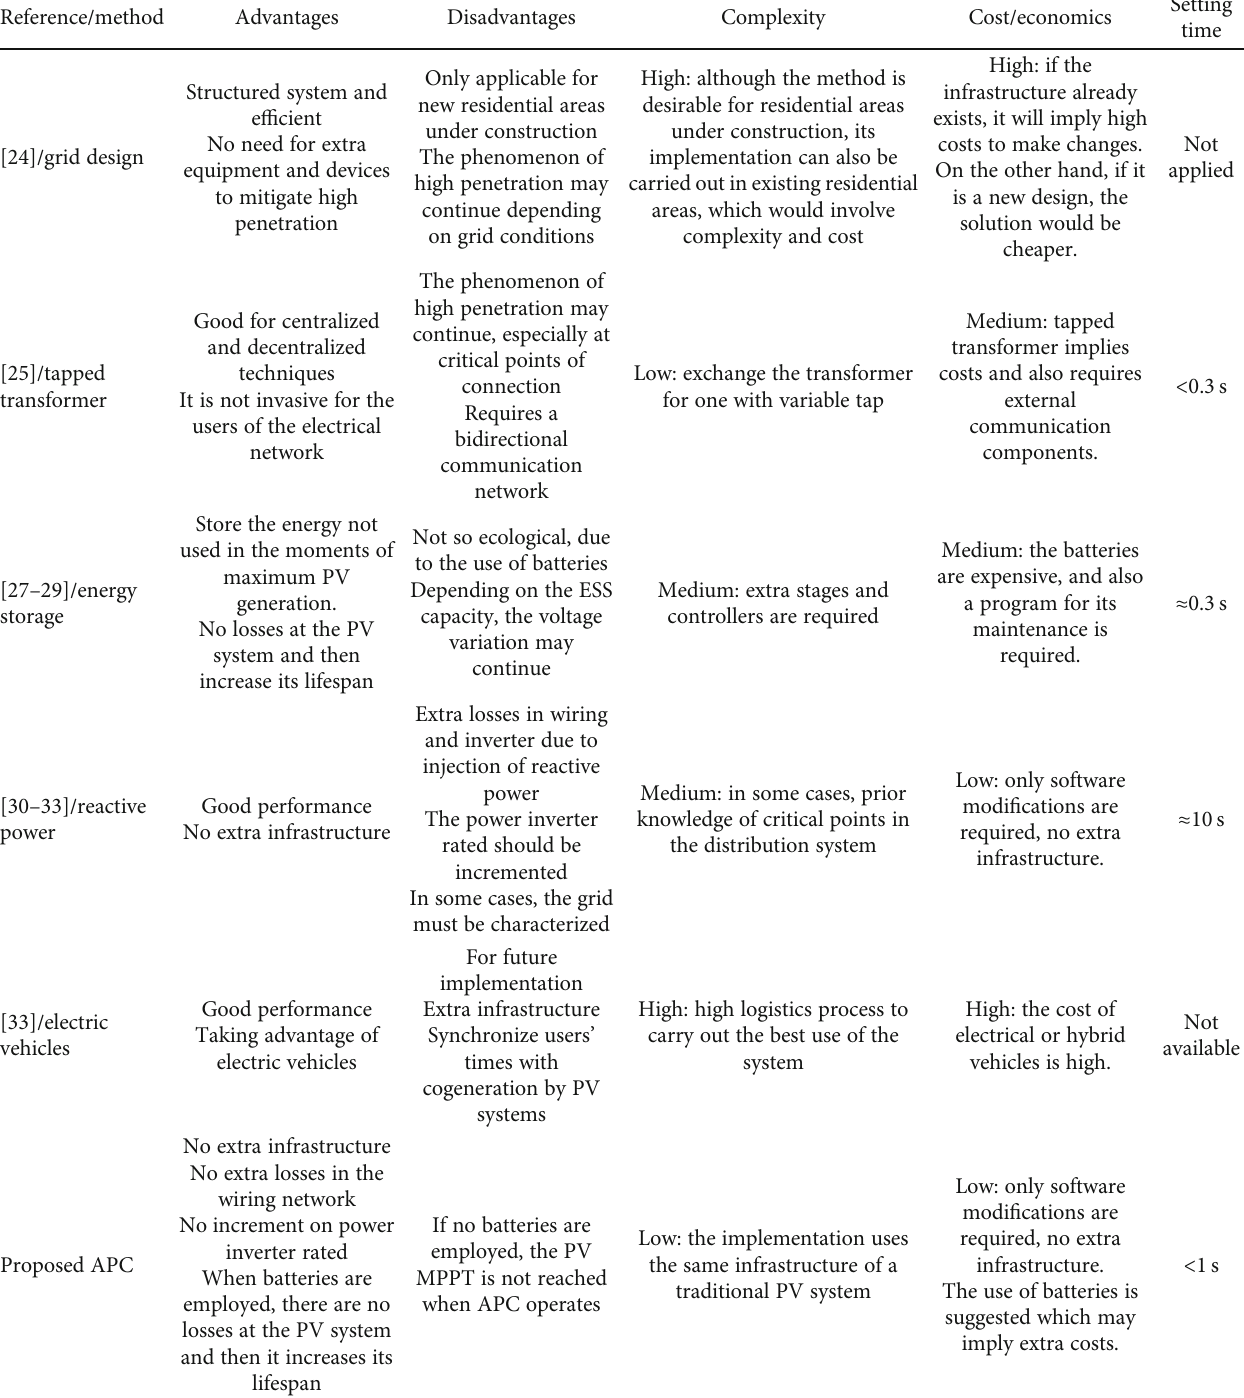
Table 3: Strategy comparison to alleviate the high PV penetration